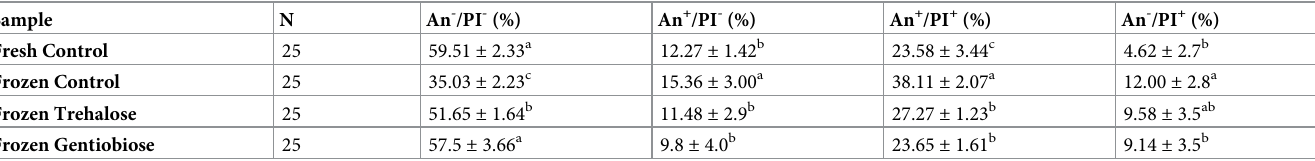
Table 3. Sperm staining by Annexin V and